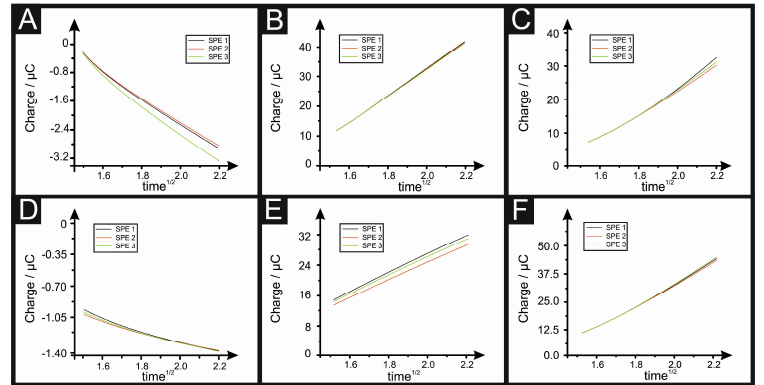
Figure 4. Anson plots resulting from using the following redox probes: 1 mM RuHex ( A ); 1 mM NADH ( B ); 1 mM dopamine ( C ); 1 mM capsaicin ( D ); 1 mM TMPD ( E ) and 1 mM ascorbic acid; ( F ) at 19.6 °C. The results of three different SPEs are presented. Table 2. Calculated electrode areas ( A real ) for SPEs using the Anson plot equations (Equations (6) and (7)) recorded at 19.6 °C for each redox probe, with the diffusion coefficient used in the calculation. The %Real , which is the percentage of A real divided by the A geo , is also presented ( N = 3). Electroactive Probe